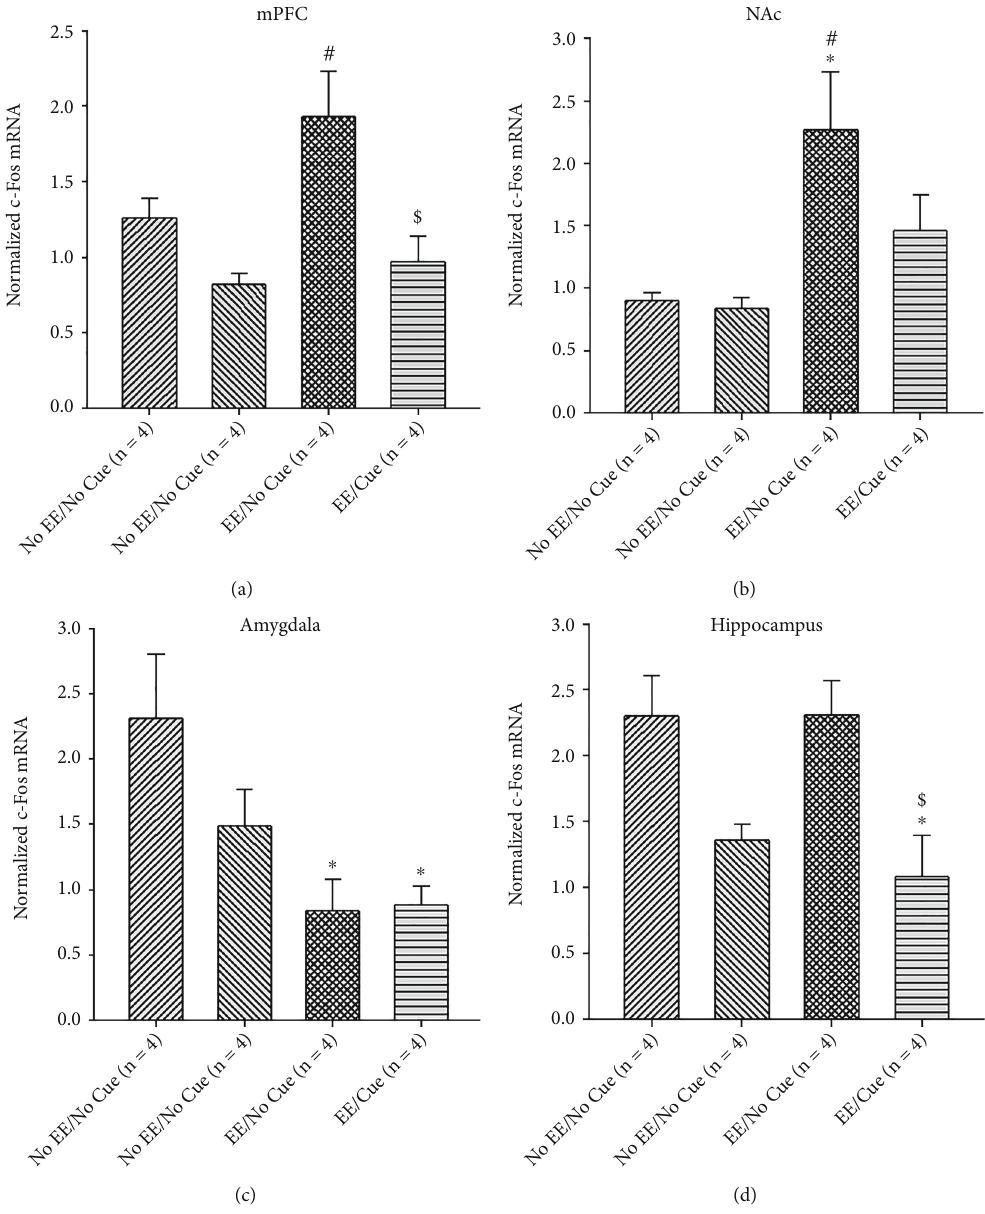
Figure 13: Mean ( ± SEM) normalized c-Fos mRNA in the mPFC (a), NAc (b), amygdala (c), and hippocampus (d) for the no EE/no cue ( n =4), no EE/cue ( n = 4 ), EE/no cue ( n = 4 ), and EE/cue groups ( n = 4 ). EE: environmental enrichment. ∗ p < 0 : 05 indicates signi fi cant di ff erences compared to the no EE/no cue group; # p < 0 : 05 indicates signi fi cant di ff erences compared to the no EE/cue group. $ p < 0 : 05 indicates signi fi cant di ff erences compared to the EE/no cue